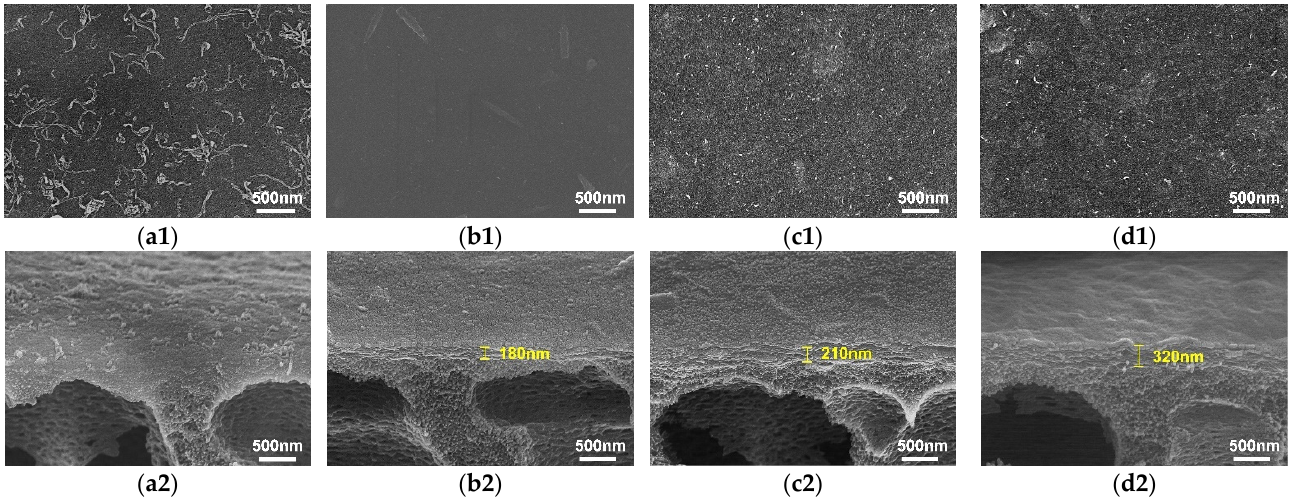
Figure 3. Surface and cross-sectional SEM images of ( a1,a2 ) the 3 ppm CNTs membrane, ( b1,b2 ) CoAl-LDH membrane, ( c1,c2 ) CNTs/LDH-3 wt.% membrane, and ( d1,d2 ) CNTs/LDH-5 wt.% membrane.